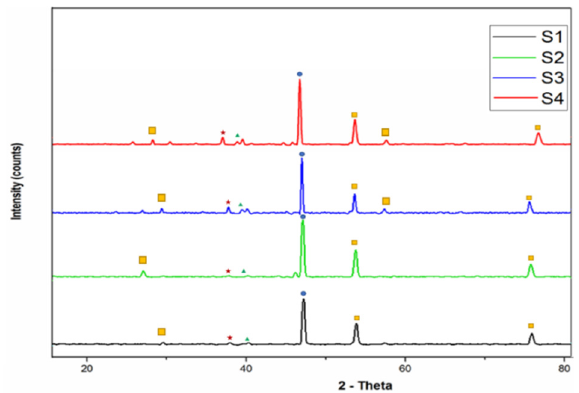
Figure 3. XRD spectra of sintered samples at different dwell times.